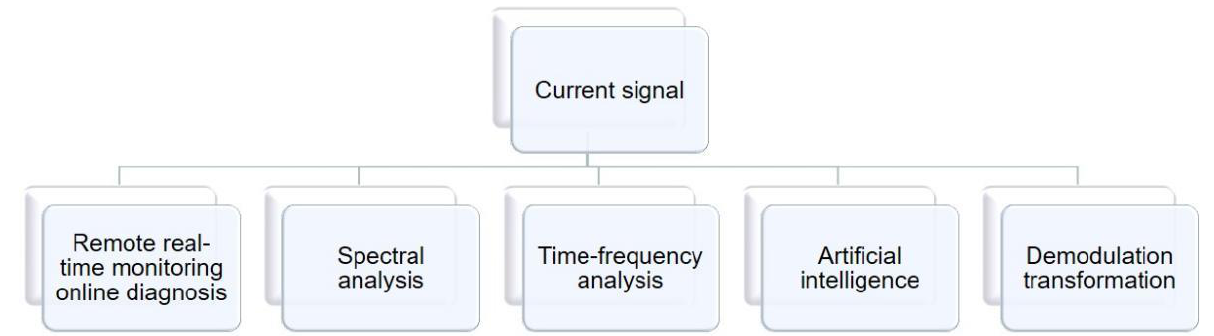
Figure 5. One-dimensional current-signal analysis methods.